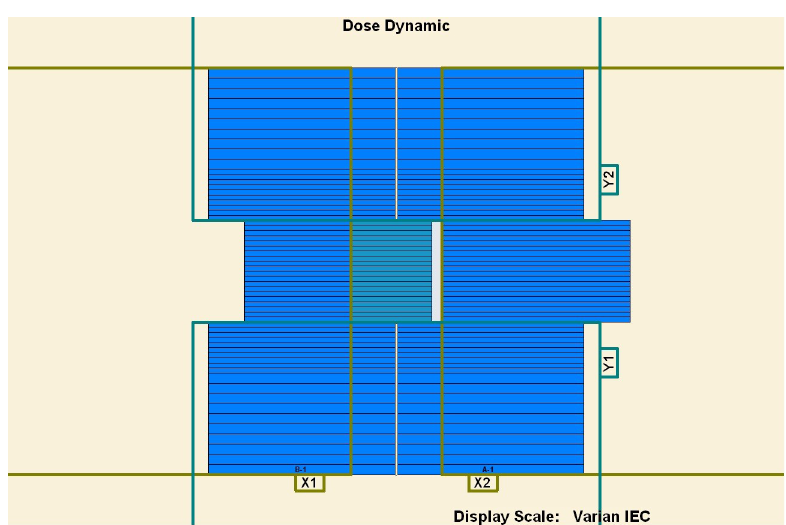
Fig 5. Five segments designed to be 1 × 10 cm 2 . (1) First segment’s center: − 4 cm. (2) Second segment’s center: − 2 cm. (3) Third segment’s center: 0 cm. (4) Fourth segment’s center: 2 cm. (5) Fifth segment’s center: 4 cm.